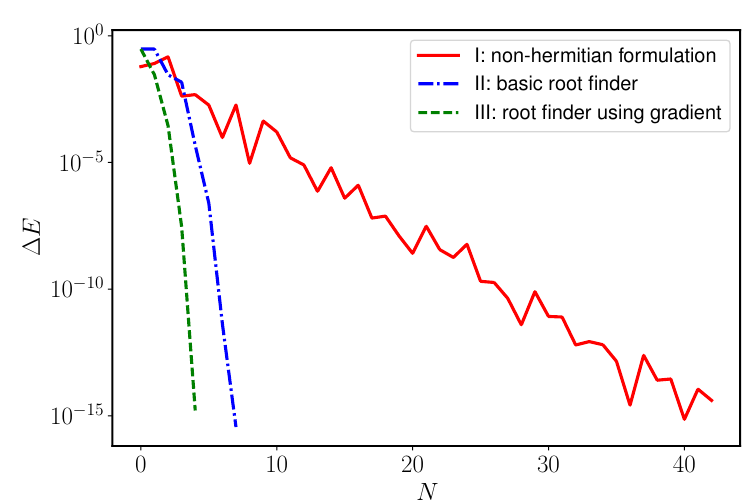
Figure 3: Convergence of the bound state energy as a function of the number of iterations for the three algorithms presented in the